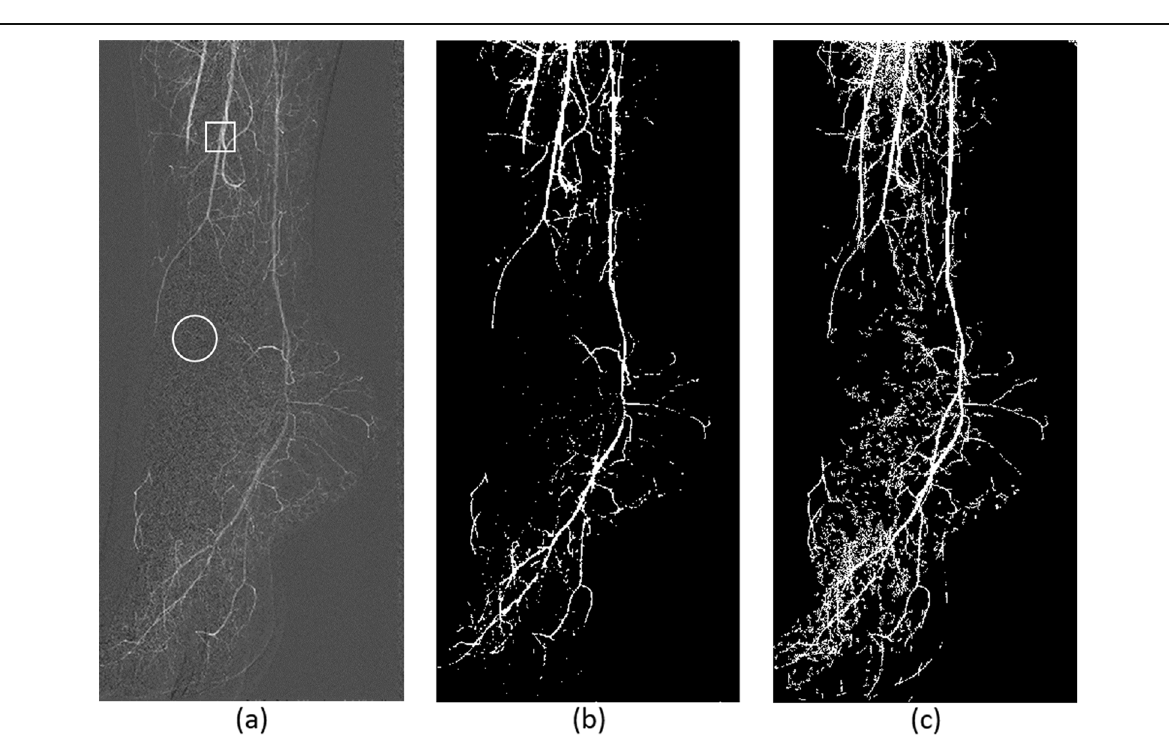
Fig. 3 a User initialization regions of interest at vessel (in rectangle) and background (in circle), at a slice selected by the user 8/24 (4th second). b Fuzzy C-means three-dimensional segmentation result at slice 8/24 (4th second). c Total vessel mask after pixel voting procedure with vessel information derived from all available